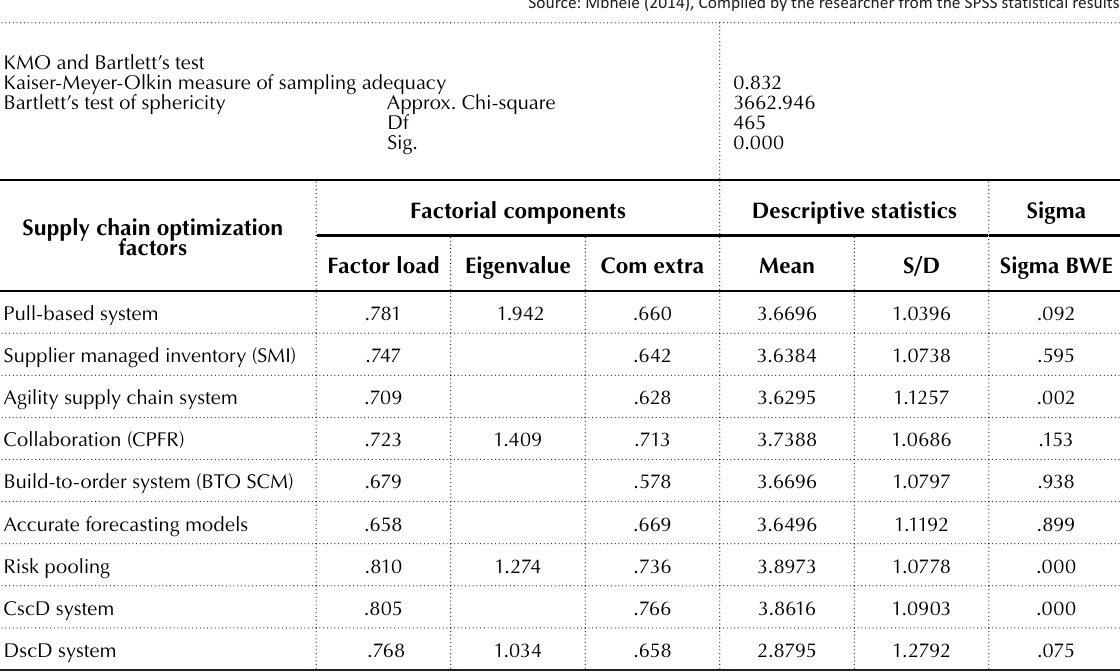
Table 1. Descriptive and factor analysis on KMO and Bartlett’s test rotated components Source: Mbhele (2014), Compiled by the researcher from the SPSS statistical results. KMO and Bartlett’s test Kaiser-Meyer-Olkin measure of sampling